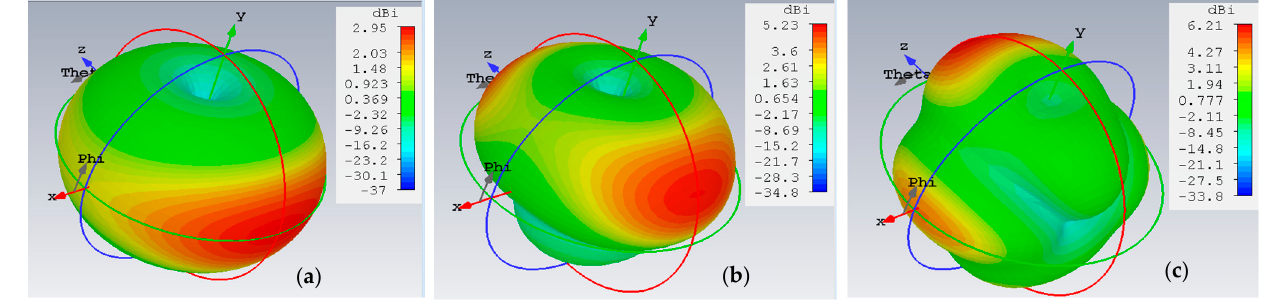
Figure 8. Simulated 3D RPs at ( a ) 3.5 GHz ( b ) 6.1 GHz ( c ) 9.25 GHz.